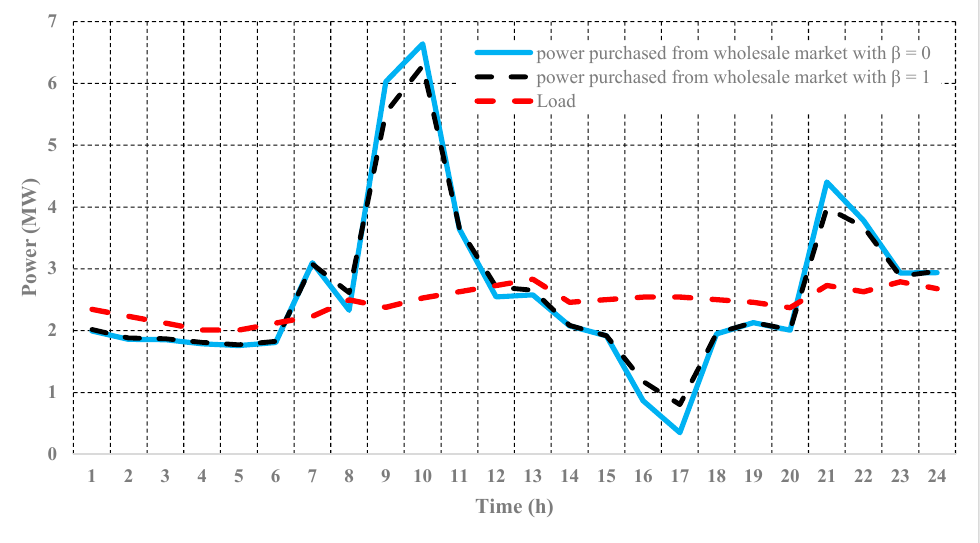
Figure 6. Power purchased from the wholesale market in the two cases.